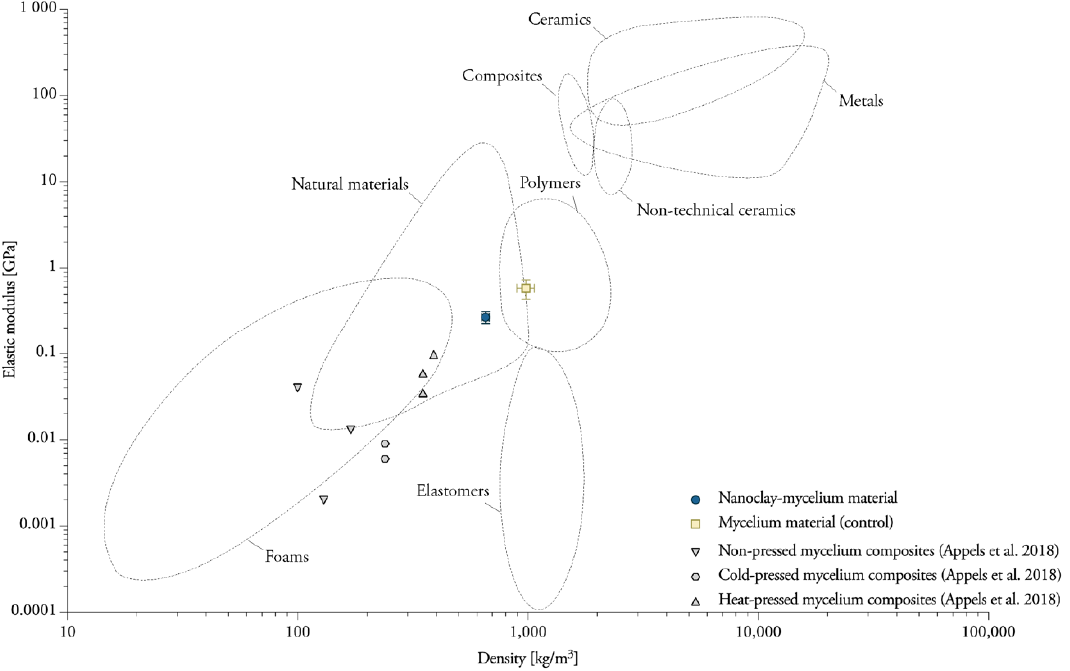
Figure 16. Overview of data about the elastic modulus for mycelium materials obtained in this and other studies. Data compiled from [3]. Plotted on Ashby chart for engineering materials [57].